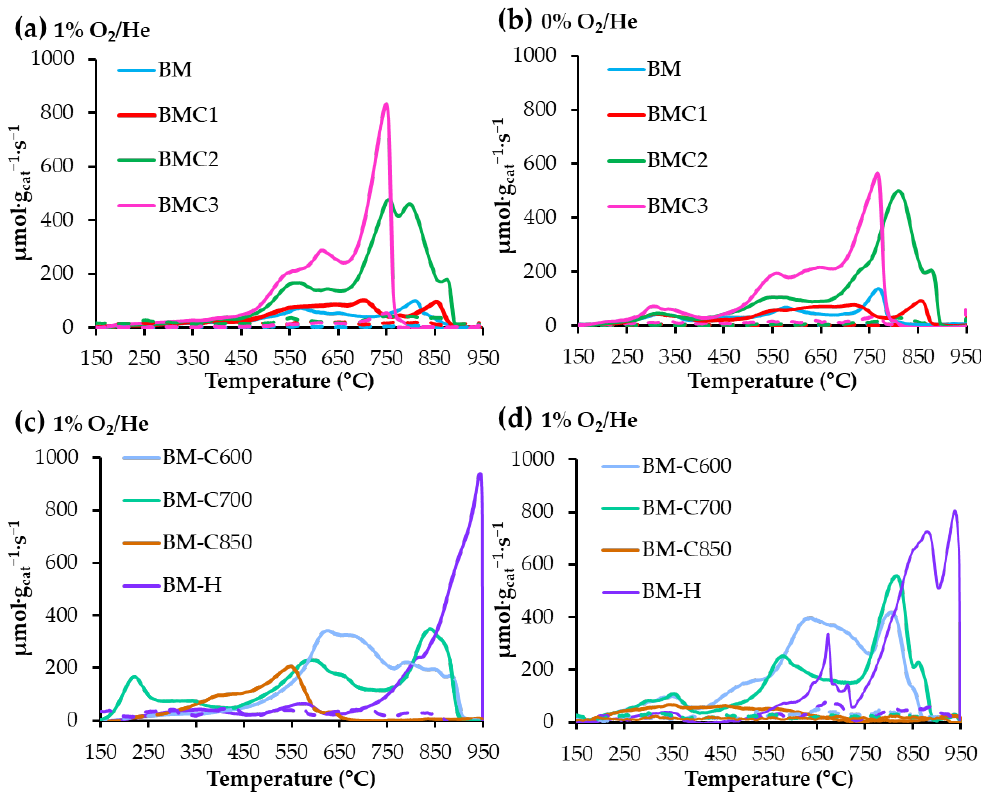
Figure A2. Evolved CO 2 and CO profiles for catalysts: ( a , c ) in (1% O 2 /He) and ( b , d ) in He.